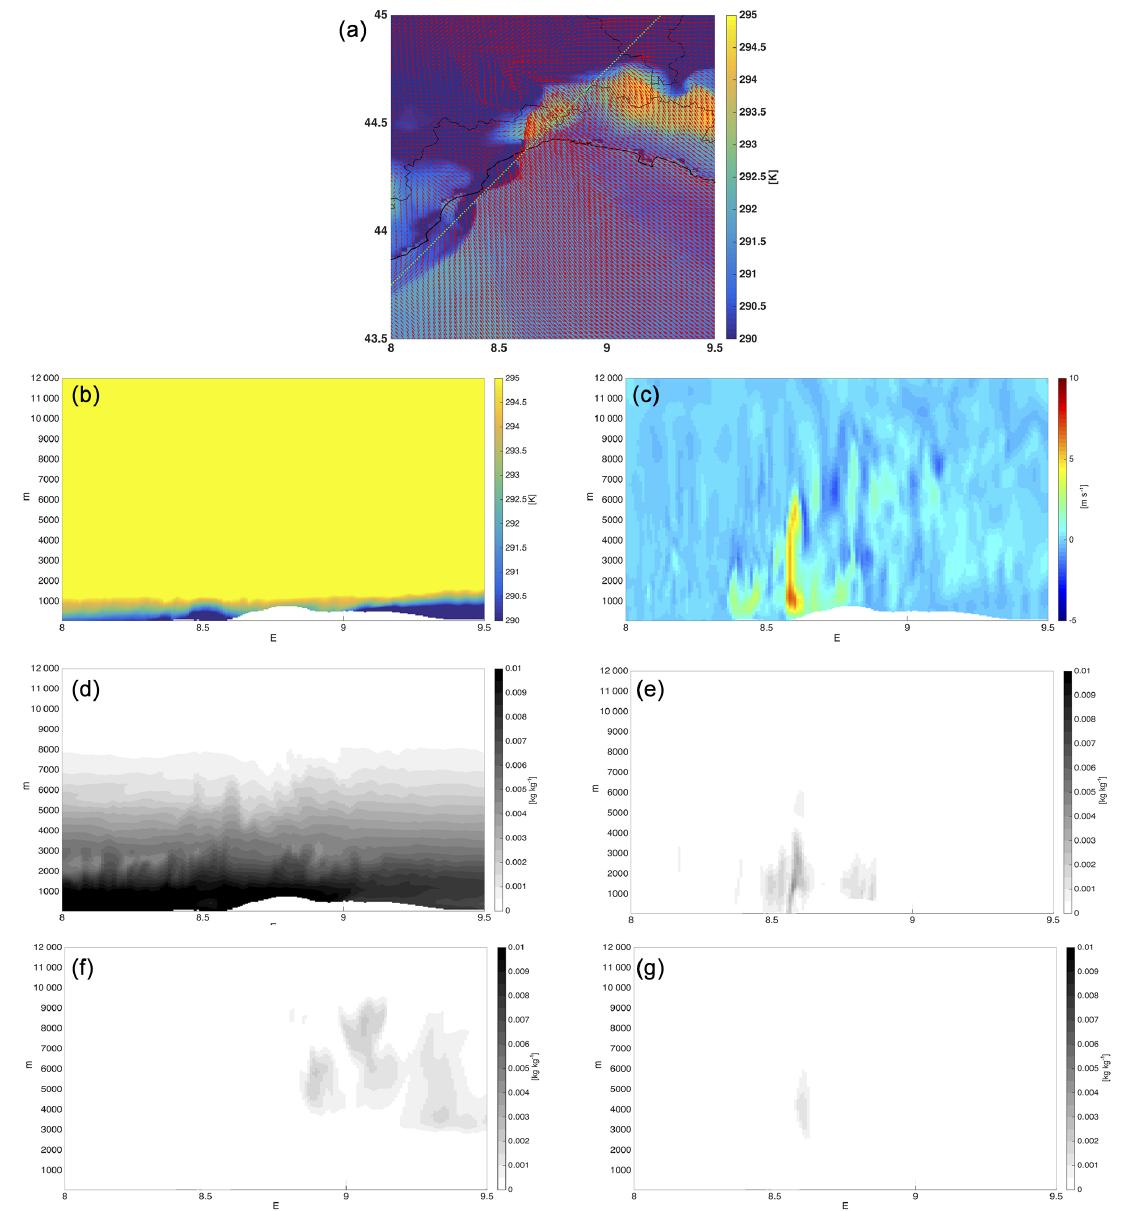
Figure 15. From member 1 at 06:00UTC 25 September 2015, panel (a) shows 2m potential temperature together with the 10m horizontal wind vectors, while panels (b–g) show vertical cross sections of potential temperature, vertical velocity, water vapor, rain water, snow and graupel mixing ratios along the cross section (green dotted) shown in (a)